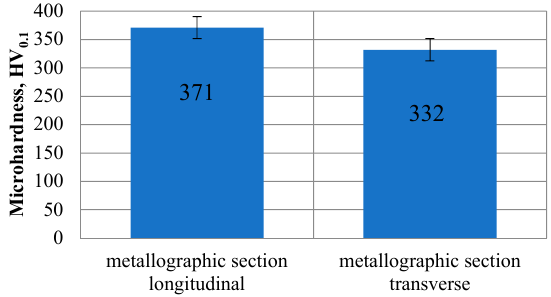
Figure 6. Microhardness measurement results for the Ti ‐ 13Nb ‐ 13Zr alloy.